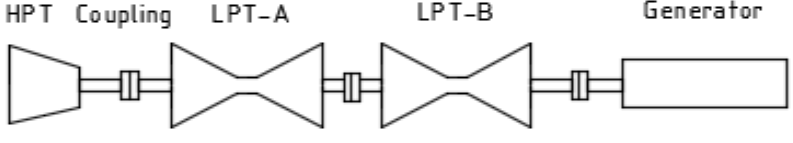
Figure 2. T/G with two (2) LPT cylinders.